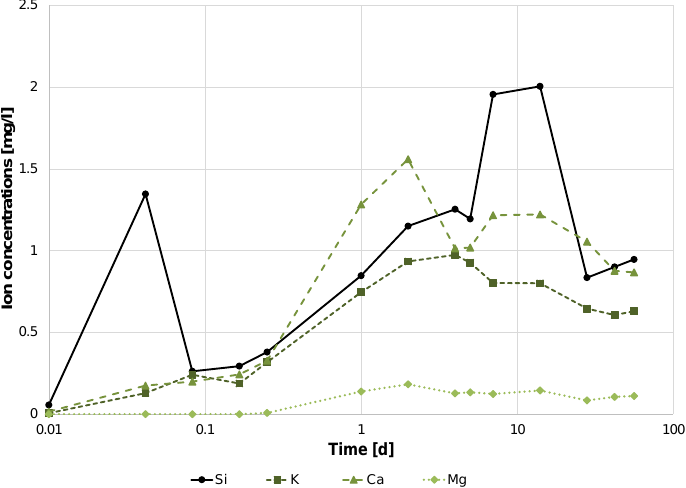
Figure 8. Ion concentration in deionised H 2 O in relation to time for glass 13-93.